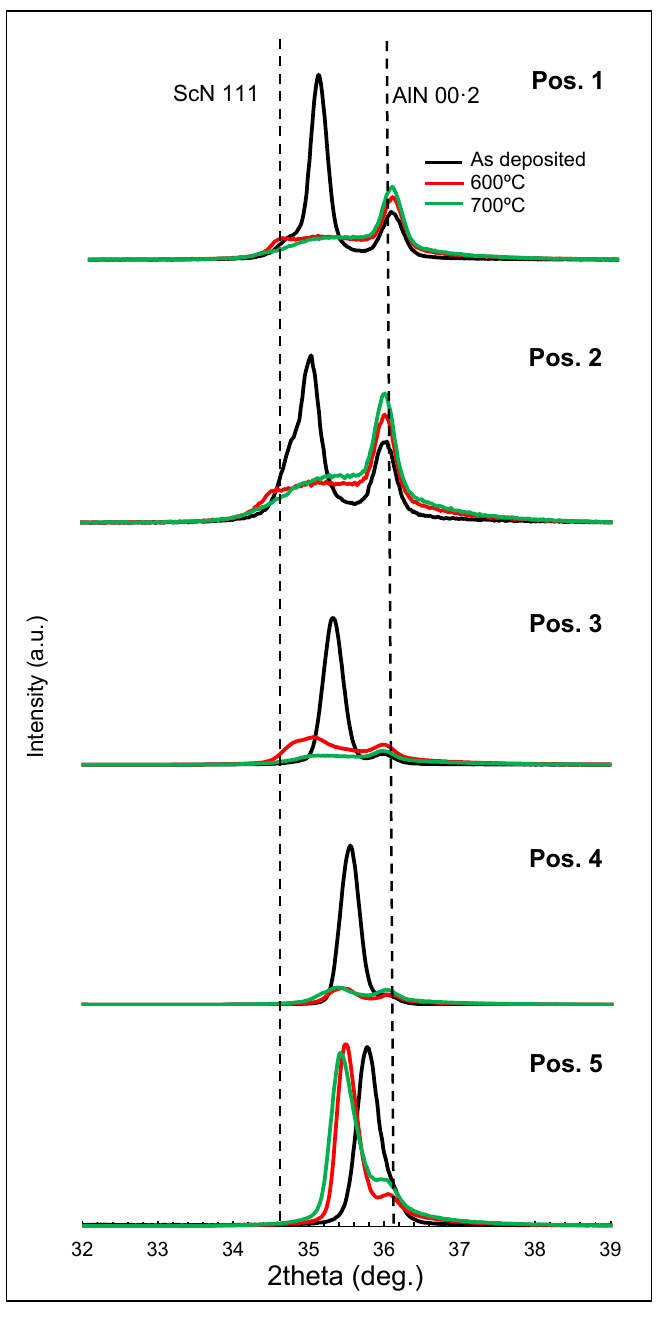
Figure 10. XRD patterns from the Al 0.7 Sc 0.3 N on Si films as deposited and after 600 °C and 700 °C thermal treatments, going from the center (Pos. 1) to the edge (Pos. 5) of the 8 ‐ inch wafer.